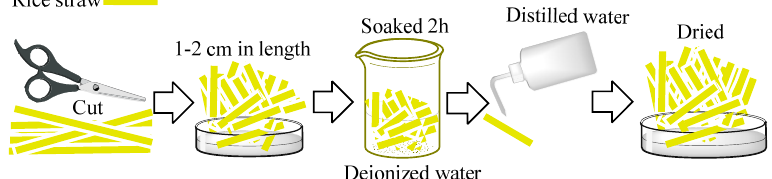
Figure 9. Preparation diagram of rice straw.